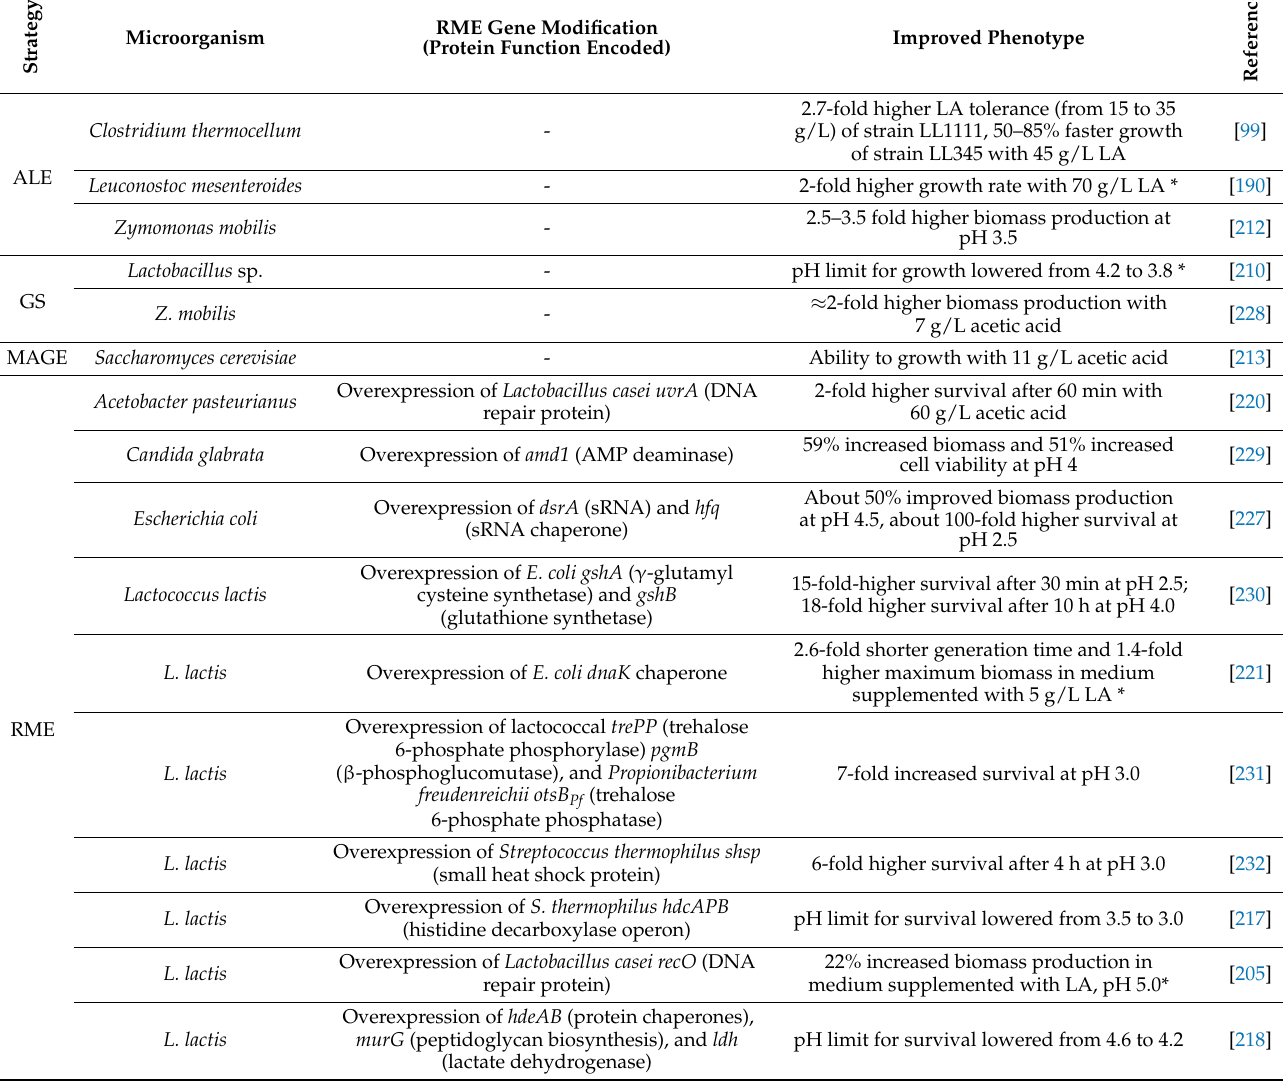
Table 3. Some metabolic engineering strategies used for improving acid tolerance in microorganisms. ALE, adaptive laboratory evolution; CM, chemical mutagenesis; MAGE, multiplex automated genome engineering; GS, genome shuffling; RAISE, Random insertional-deletional strand exchange mutagenesis; RME, rational metabolic